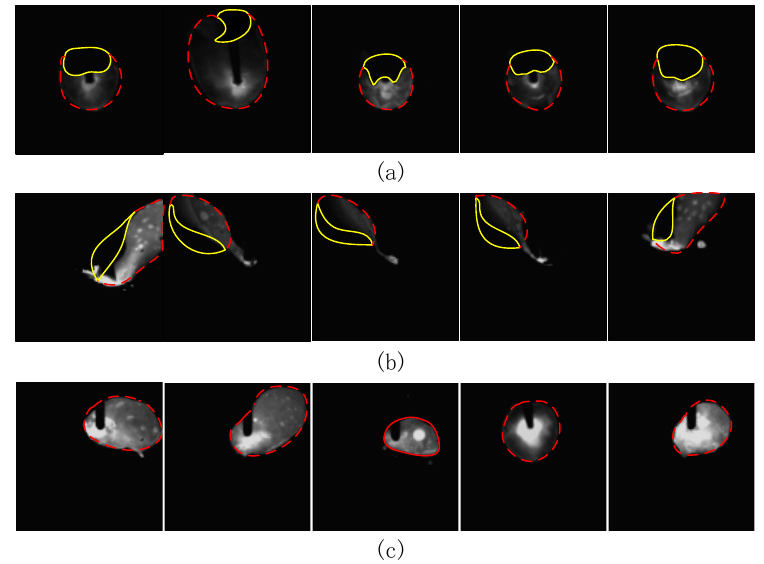
Figure 5. Part of the sample set images. ( a ) welding through; ( b ) welding deviation; ( c ) normal welding.